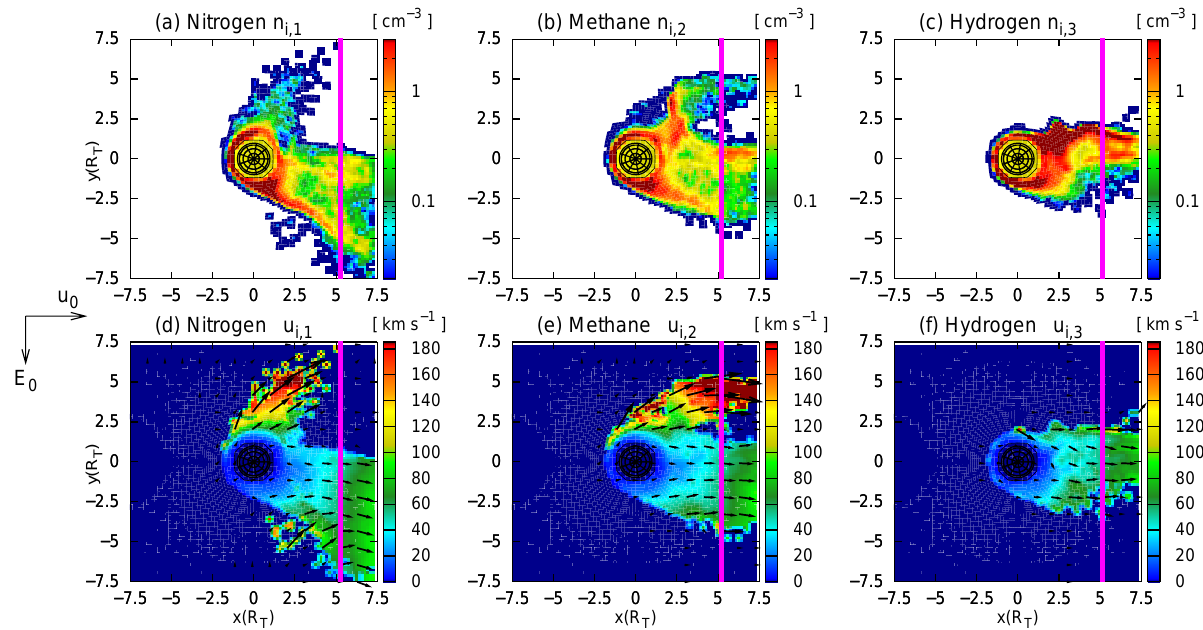
Fig. 11. Run #5 : Influence of a tangential discontinuity on Titan’s plasma tail. The discontinuity denotes a reversal of the magnetic field direction from B ∝ − e z to B ∝ + e z . The figure shows the ionospheric plasma parameters when the discontinuity is located at x = +5 R T , as denoted by the magenta bars. In other words, in the ( x < 5 R T ) half space, E points in ( − y ) direction, while for ( x > 5 R T ) , it is directed in (+ y ) direction.